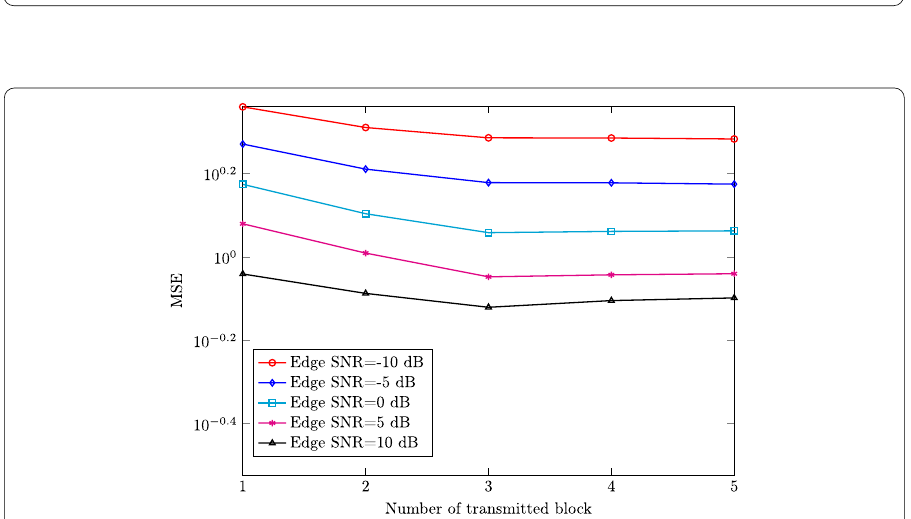
Fig. 12 MSE over time of SFB-CBH with r fl = r bl = 0.11 in various cell-edge SNRs and time-variant